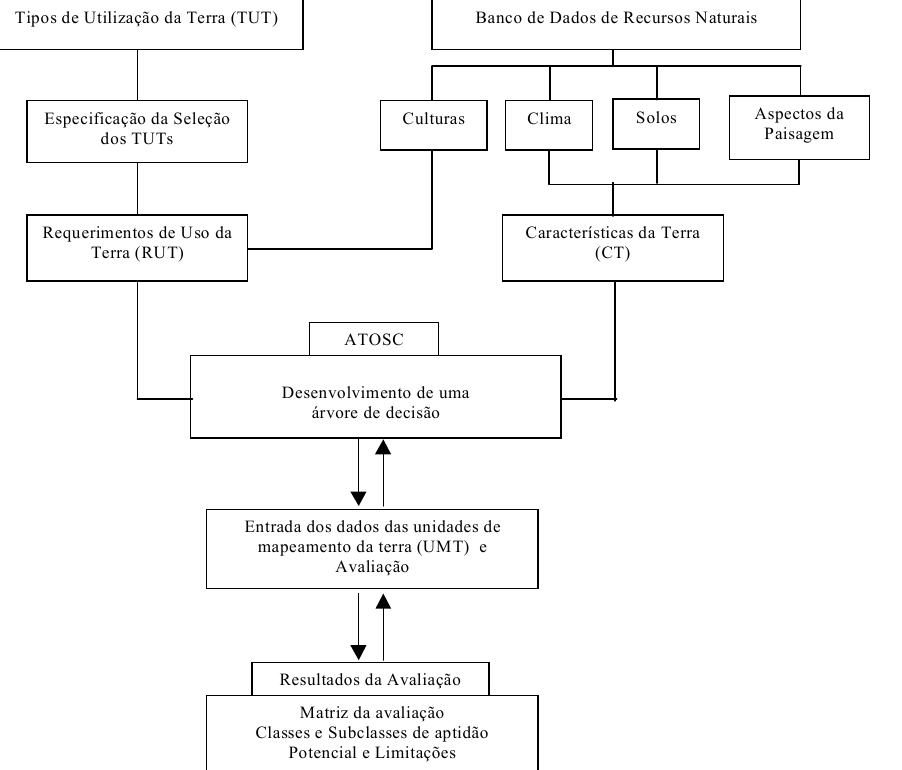
Figura 1. Fluxograma da avaliação das terras utilizando-se o ATOSC (adaptado de Yizengaw & Verheye,